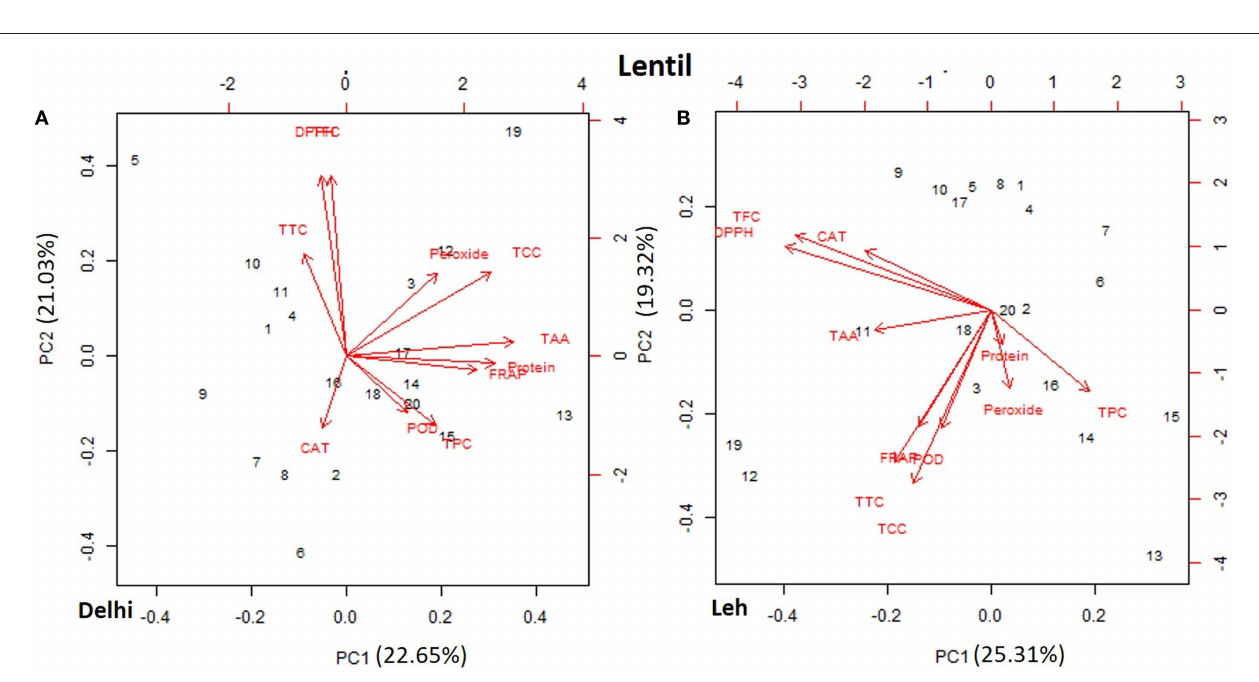
FIGURE 4 | Principal component plot derived from various antioxidant activities [1,1-diphenyl-2-picrylhydrazyl (DPPH), ferric-reducing antioxidant power (FRAP), peroxide, total tocopherols content (TTC), total carotenoids content (TCC), total ascorbic acid (TAA), peroxidase (POD), and catalase (CAT)], TPC, and TFC contents in the lentil microgreens when grown at (A) normal altitude (Delhi) and (B) high altitude (Leh) conditions.